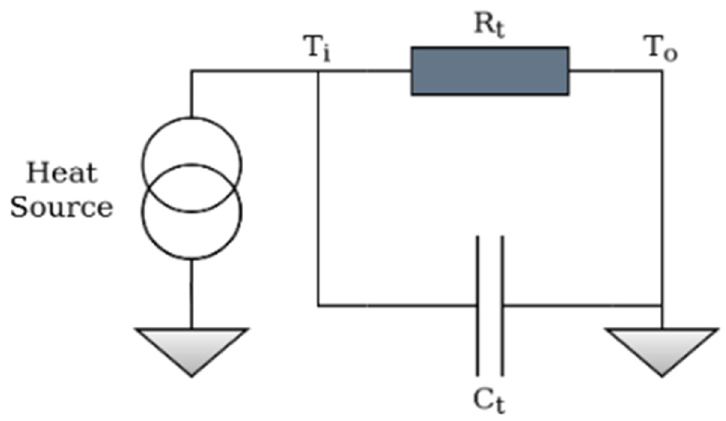
Figure 4. Room simplified equivalent thermal diagram.